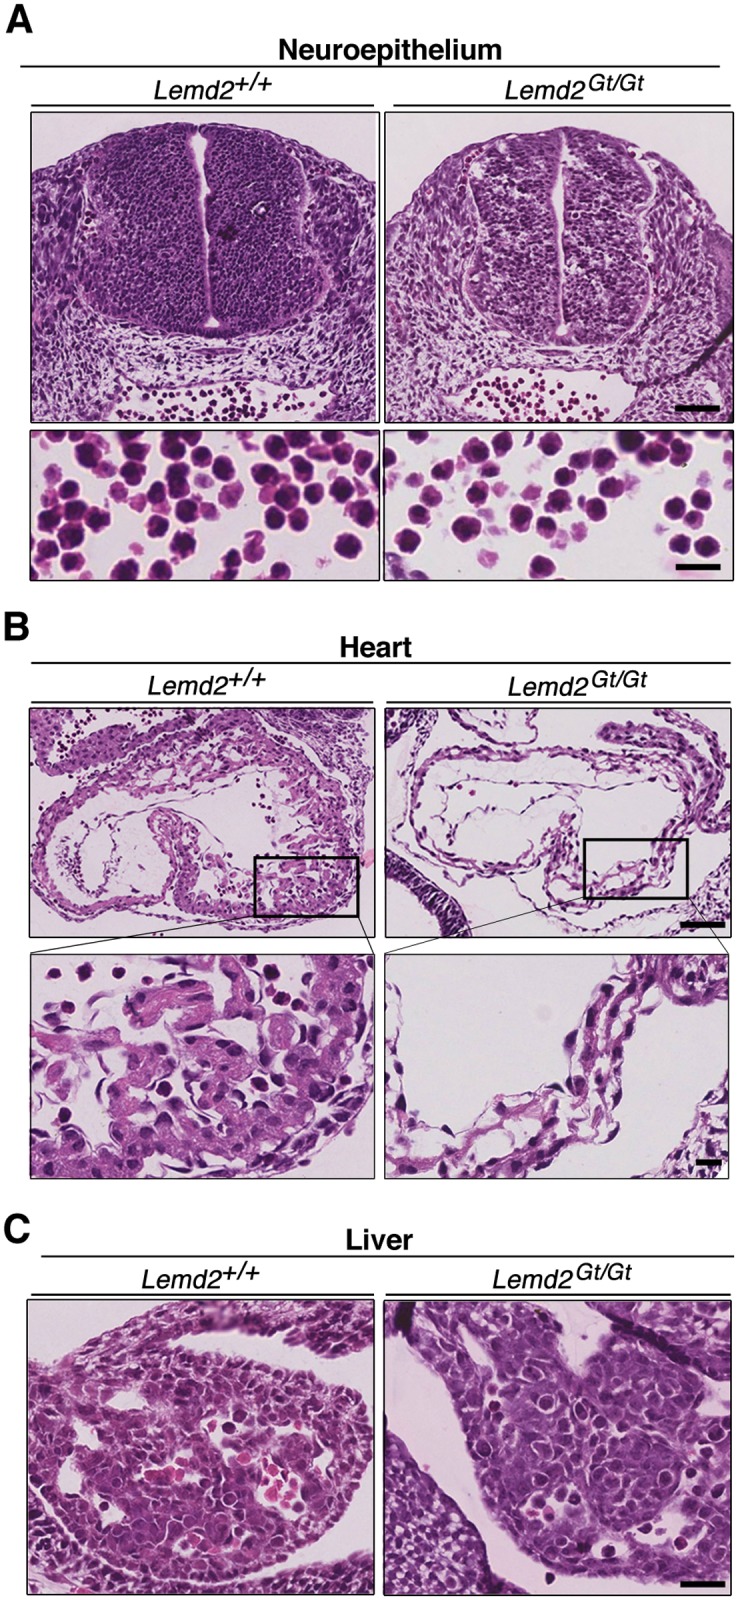
Impaired neurogenesis and cardiogenesis in Lemd2
Gt/Gt embryos.(A-C) Histological sections of Lemd2
+/+ (left) and Lemd2
Gt/Gt (right) E10.5 embryos stained with H&E. (A) Top panels: transverse sections of the posterior region of the neural tube. Lower panels: higher magnification views of blood cells from panel A. (B) Sagittal sections of heart. Lower panels are high-magnification views of boxed areas. (C) Sagittal sections of liver. Bars: A and B top, 50 μm; A and B bottom and C, 15 μm.